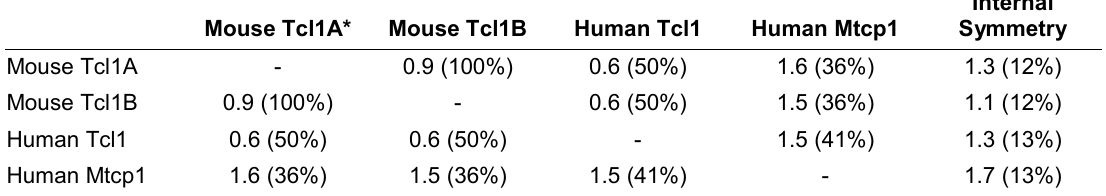
Structural Similarity for Mouse Tcl1, Human Tcl1, and Human